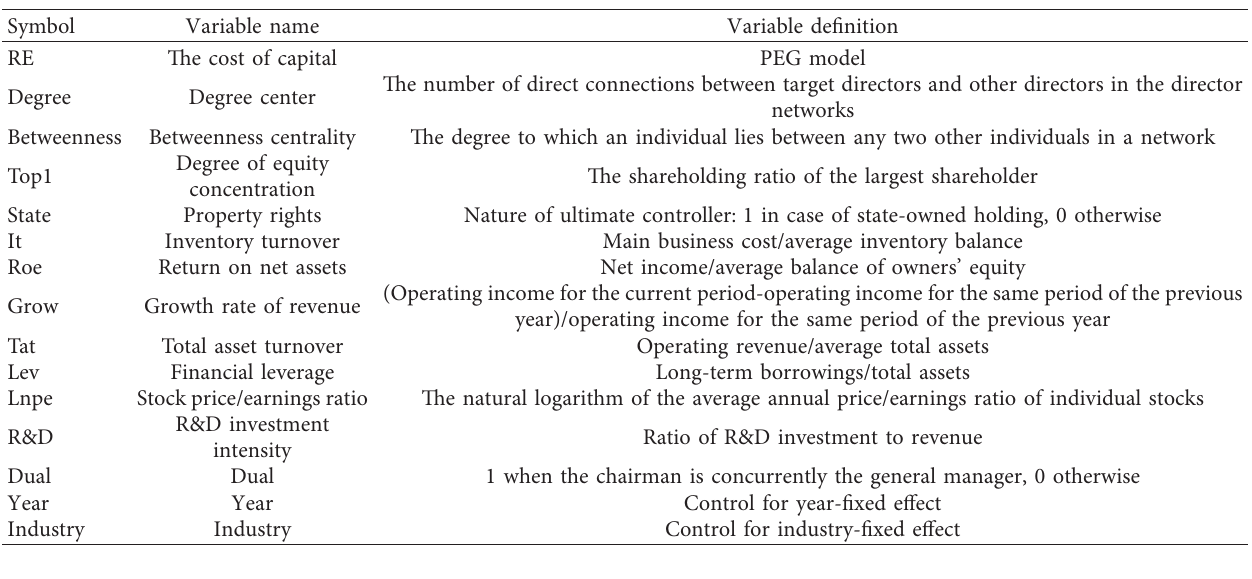
Table 1: Variable